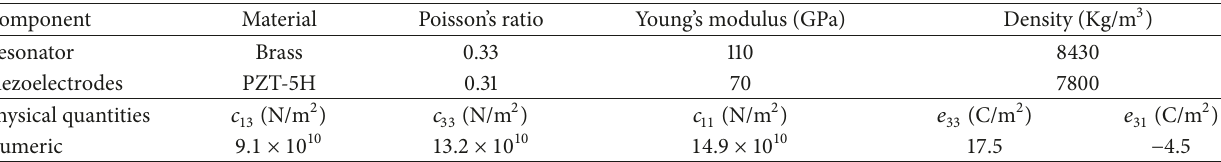
Table 1: Parameters of materials and piezoelectric constants of PZT-5H.